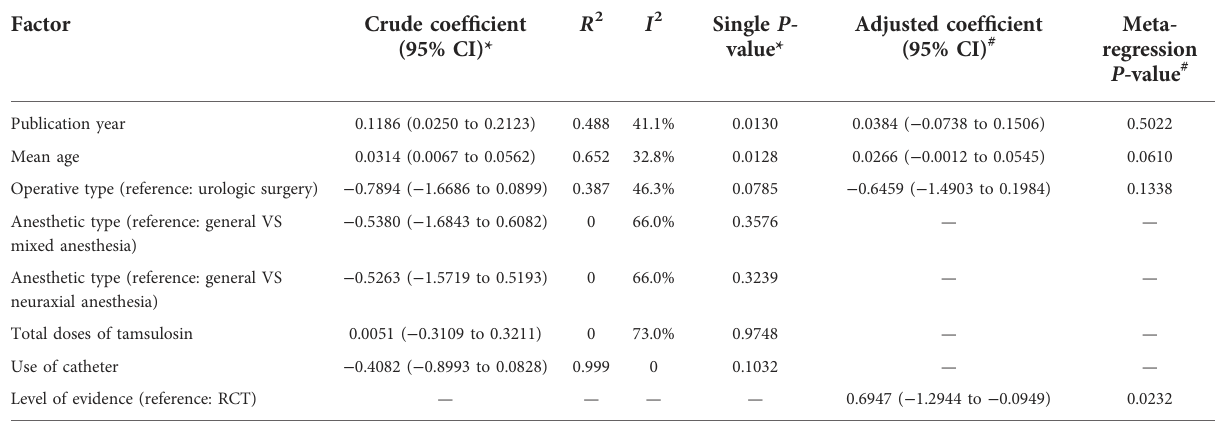
TABLE 5 Outcomes of the meta-regression.